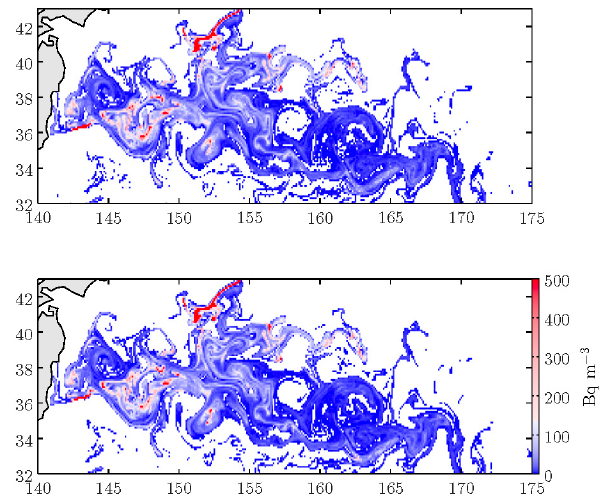
137 Fig. B1. Modeled 137 Cs concentration within the mixed layer on Fig. 12. Modeled Cs concentration within the mixed layer on June 20 computed using June 20 computed using 2 × 10 7 particles (top) and 4 × 10 7 par- 2*10^7 particles (top) and 4*10^7 particles (bottom). Colors, source domain and source 137 Cs concentration values were cut off at the detection limit (1.5 Bq strength as in Fig. 5. ticles (bottom). Colors, source domain and source strength as in -3 m ). Fig. 5. 137 Cs concentration values were cut off at the detection limit (1.5Bqm − 3 )